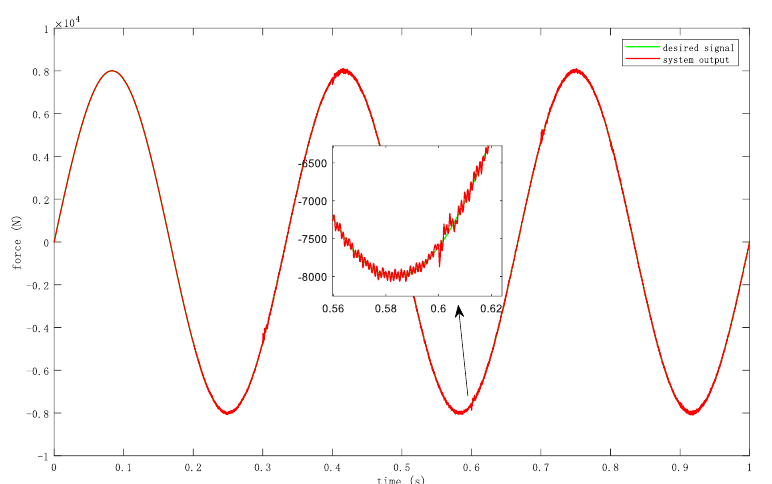
Figure 17. System loading output at 3 Hz frequency.